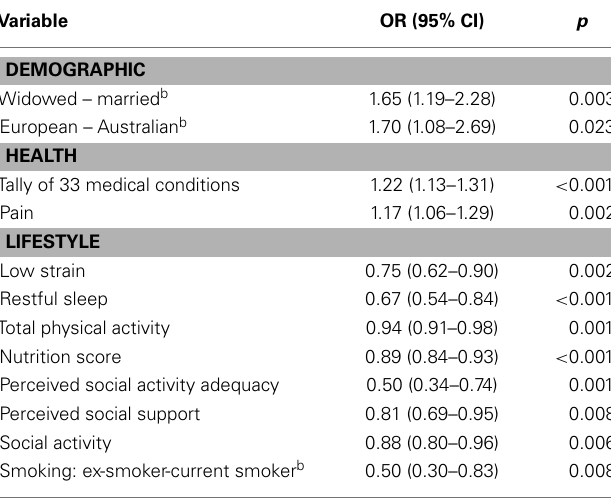
Table 2 | Significant associations between demographic, health, and lifestyle variables and not aging well at baseline (1994) ( n = 978) a